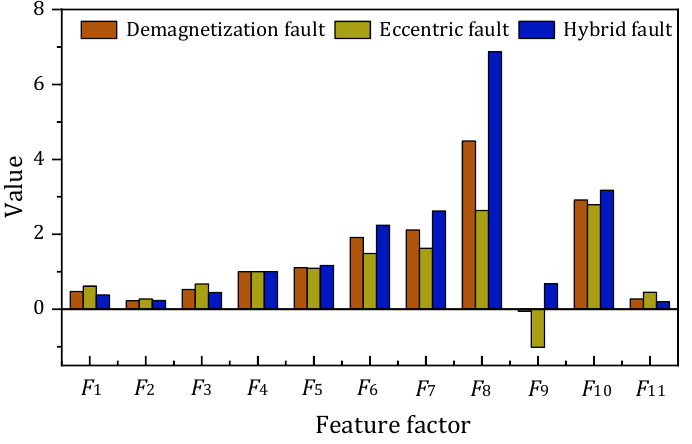
Figure 7. Characteristic factors of different rotor faults.